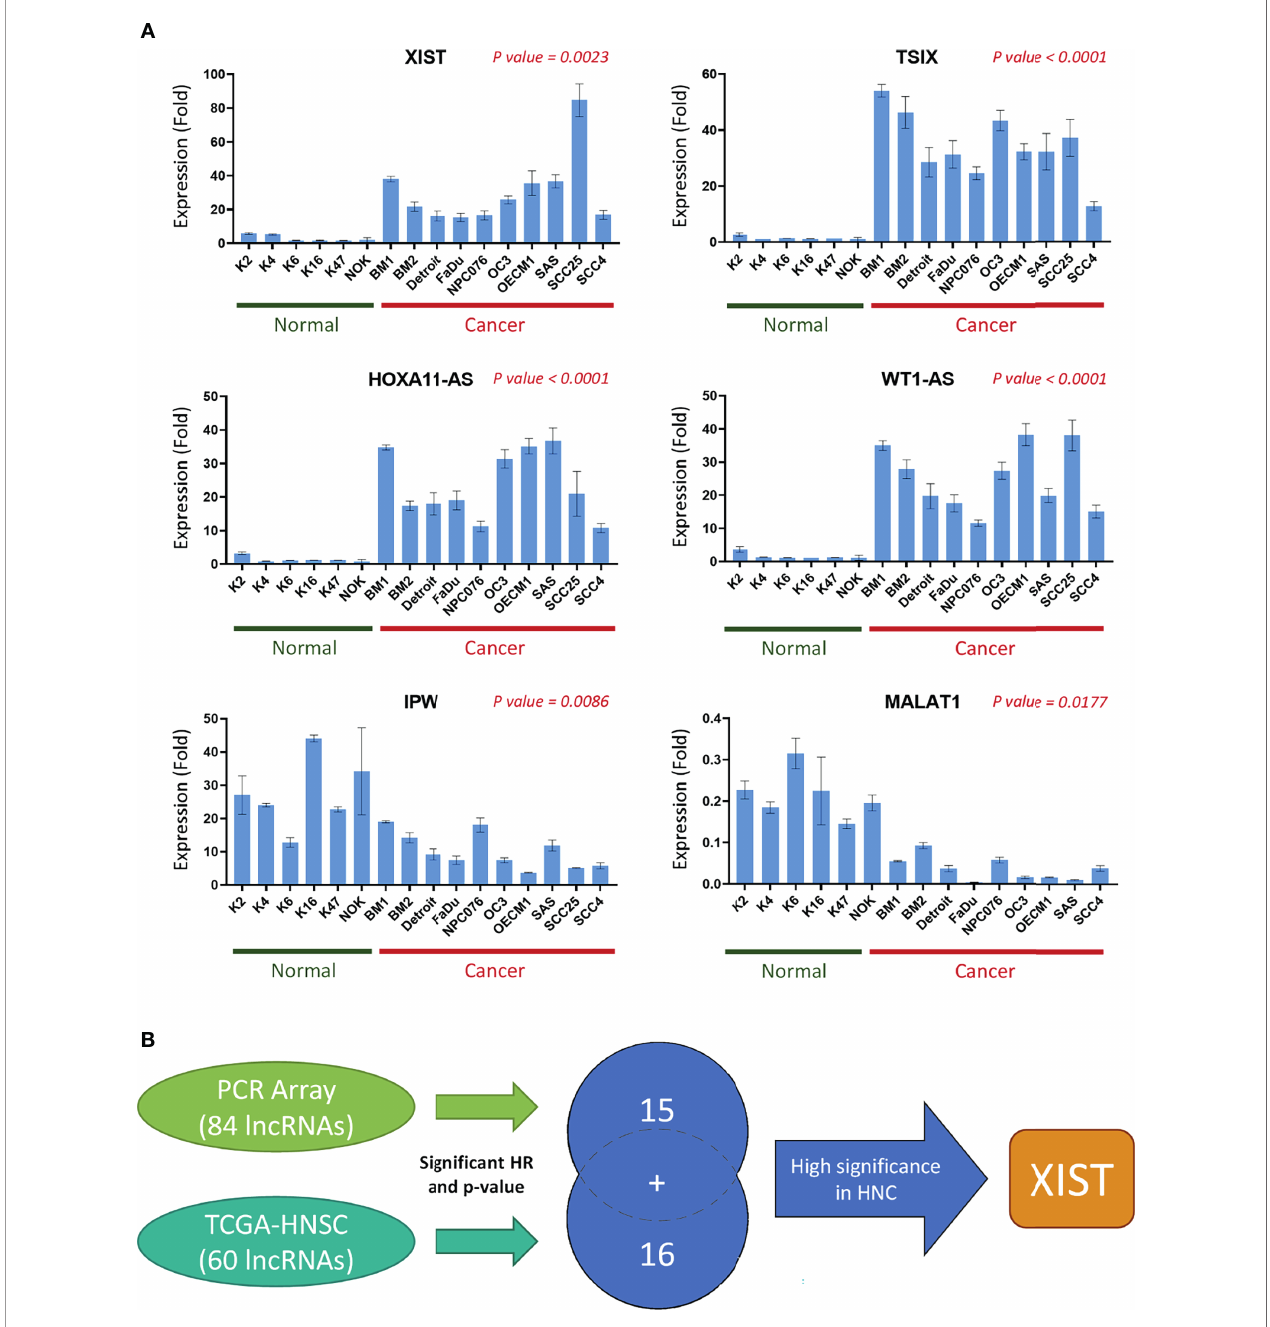
FIGURE 5 | A panel of 31-lncRNA signature predicts the prognosis of HNC. (A) The 15 PCR array Panel lncRNAs were veri fi ed with various HNC cell lines (n = 10) and normal keratinocytes (n = 6) using RT-qPCR. The six most signi fi cantly dysregulated lncRNAs are shown. P-values were calculated using t-test, where p-value ≤ 0.05 was considered signi fi cant. (B) Schematic fl owchart of the systematic screening process. A total of 31 lncRNAs were found to be signi fi cantly correlated with HNC prognosis, including 15 lncRNAs found through the PCR array, and 16 found through TCGA database